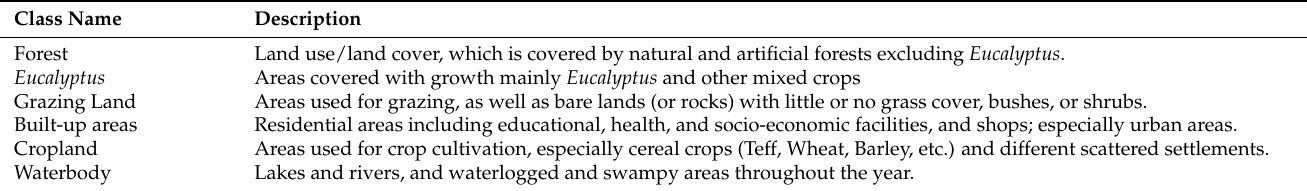
Table 2. Characteristics of identified land cover classes in the study area.